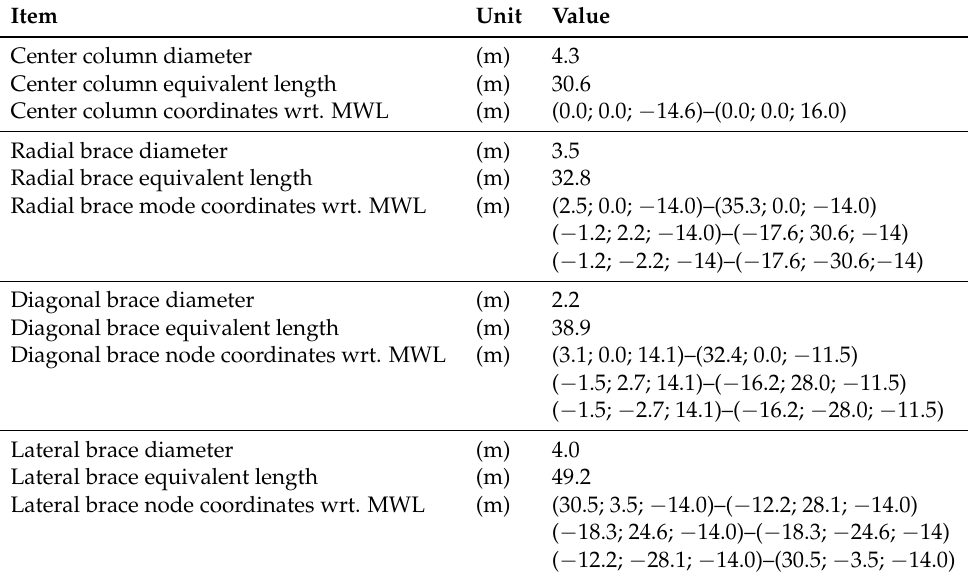
Table 5. Definition of component position and dimensions.